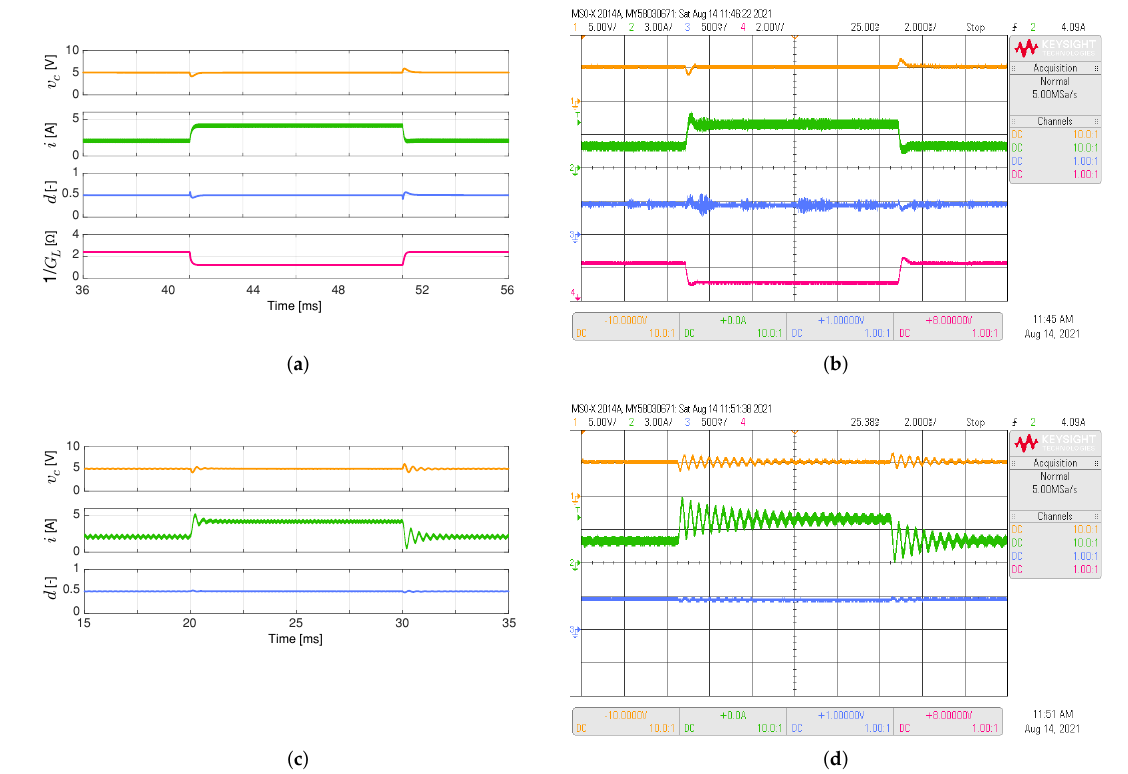
Figure 4. Simulated ( a , c ) and experimental ( b , d ) dynamic responses of the buck converter when the load resistance is a 50 Hz square waveform between 1.2 Ω and 2.4 Ω , and a duty cycle of 0.5: ( a , b ) adaptive PI-PBC controller, ( c , d ) PI controller. CH1: v c (5 V/div), CH2: i (3 A/div), CH3: d (500 mV/div), CH4: 1/ G L ( 2 V/div) (it is calculated only by the PI-PBC controller), and time base of 2ms.